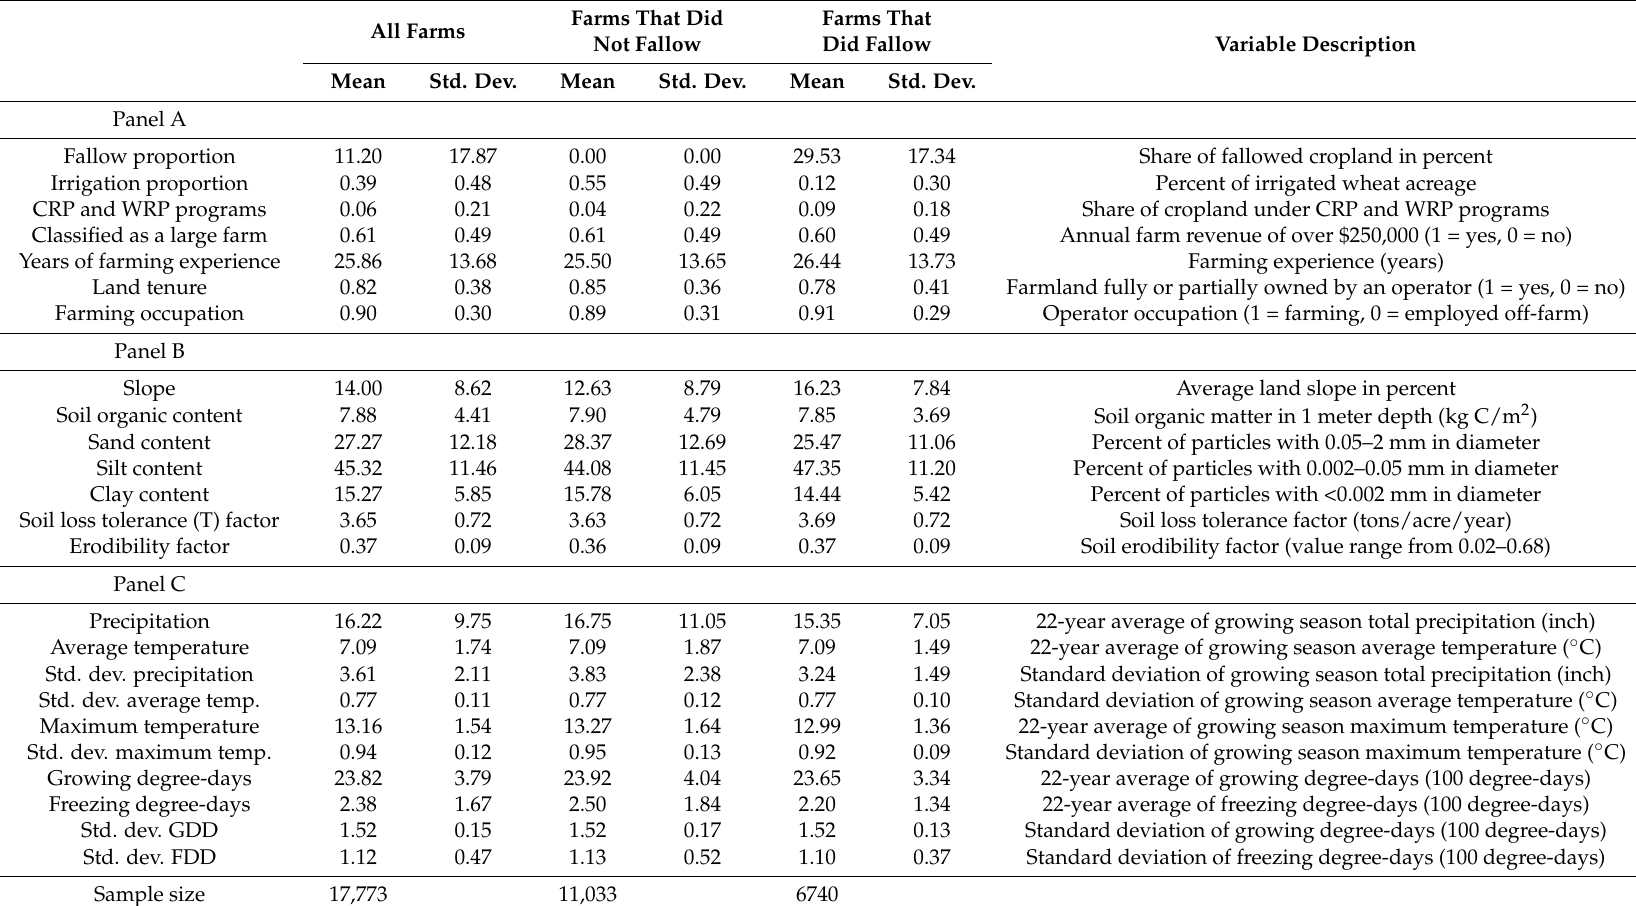
Table 1. Summary of statistics of wheat farms in the Pacific Northwest region from the U.S. Census of